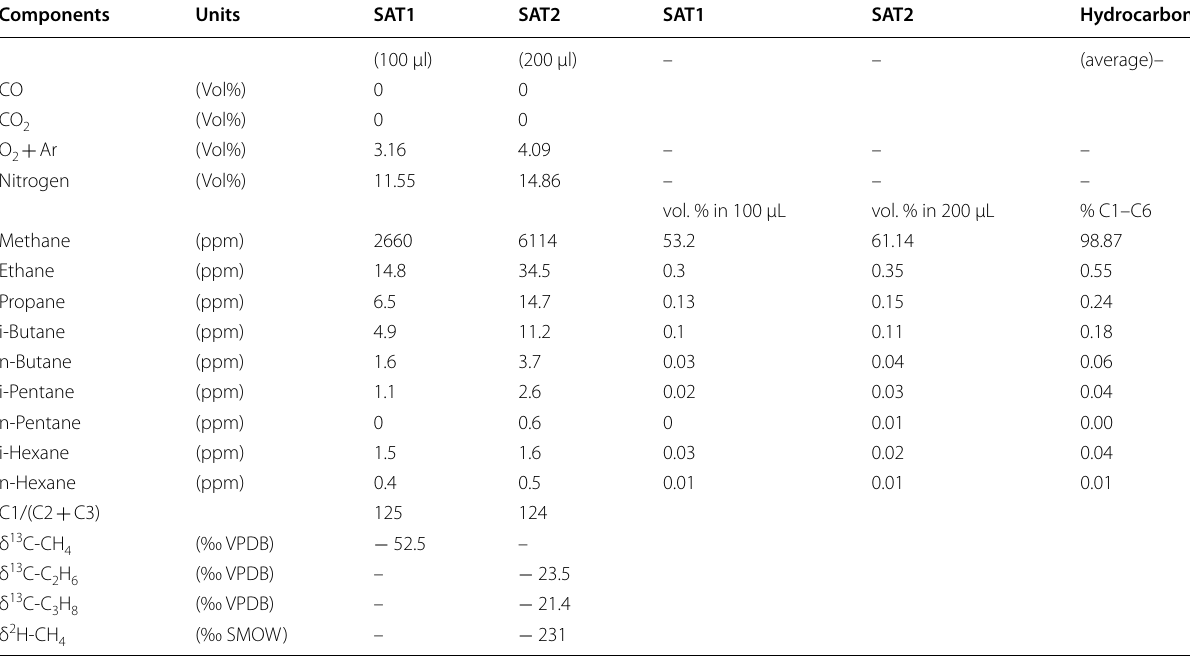
Table 5 Chemical and stable isotopic composition of the gas retrieved from Satigny